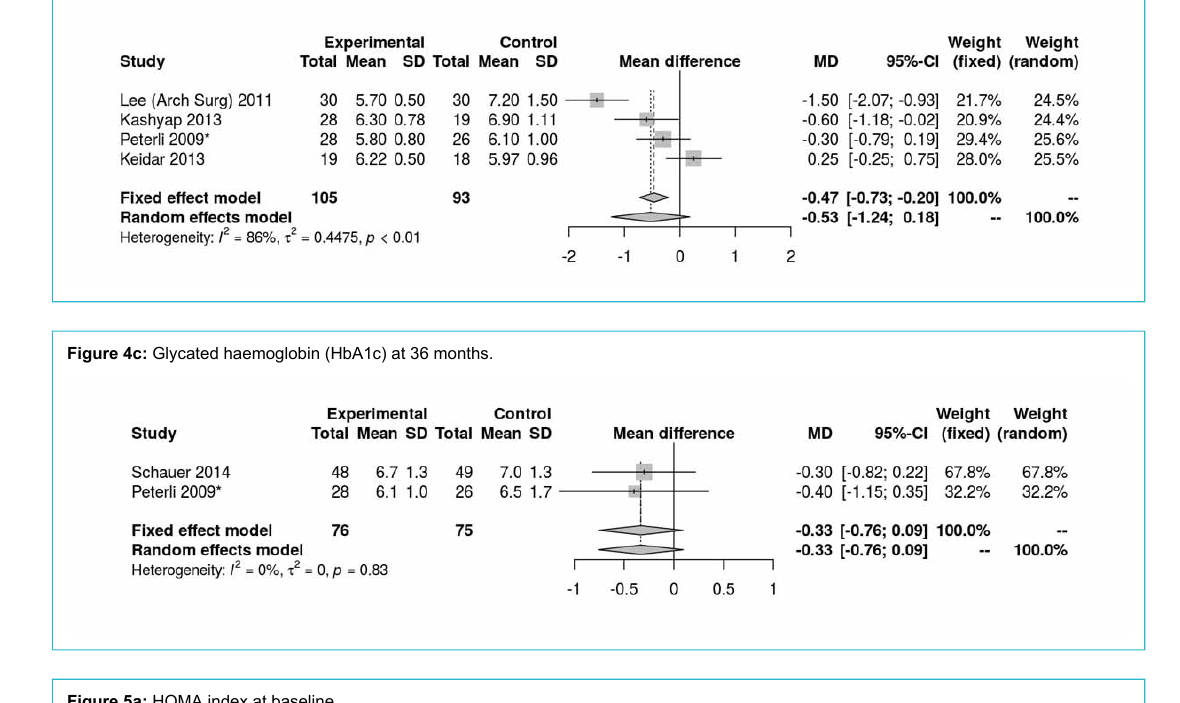
Figure 5a: HOMA index at baseline.